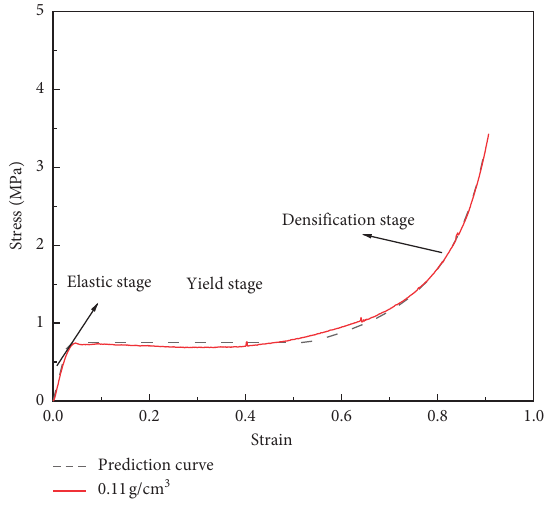
Figure 14: 0.11g/cm 3 prediction and test stress-strain curve. Table 6: The mechanical parameters of 0.11g/cm 3 specimen. Elasticity